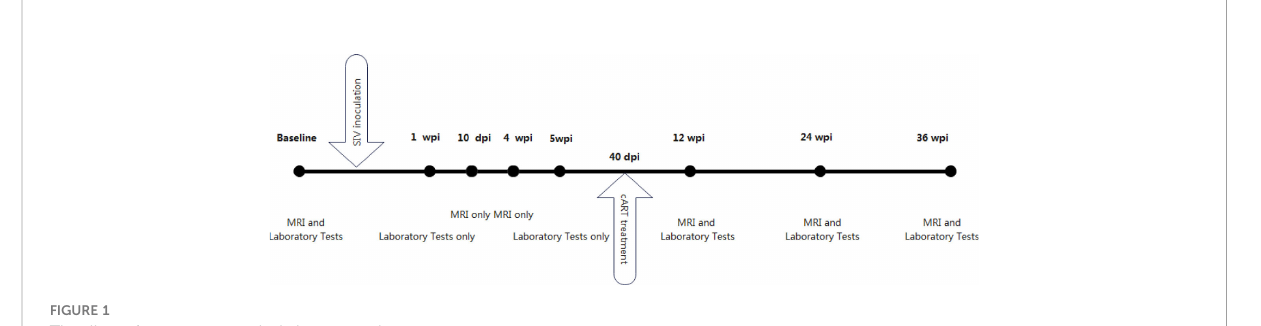
FIGURE 1 Timeline of macaques analysis in our